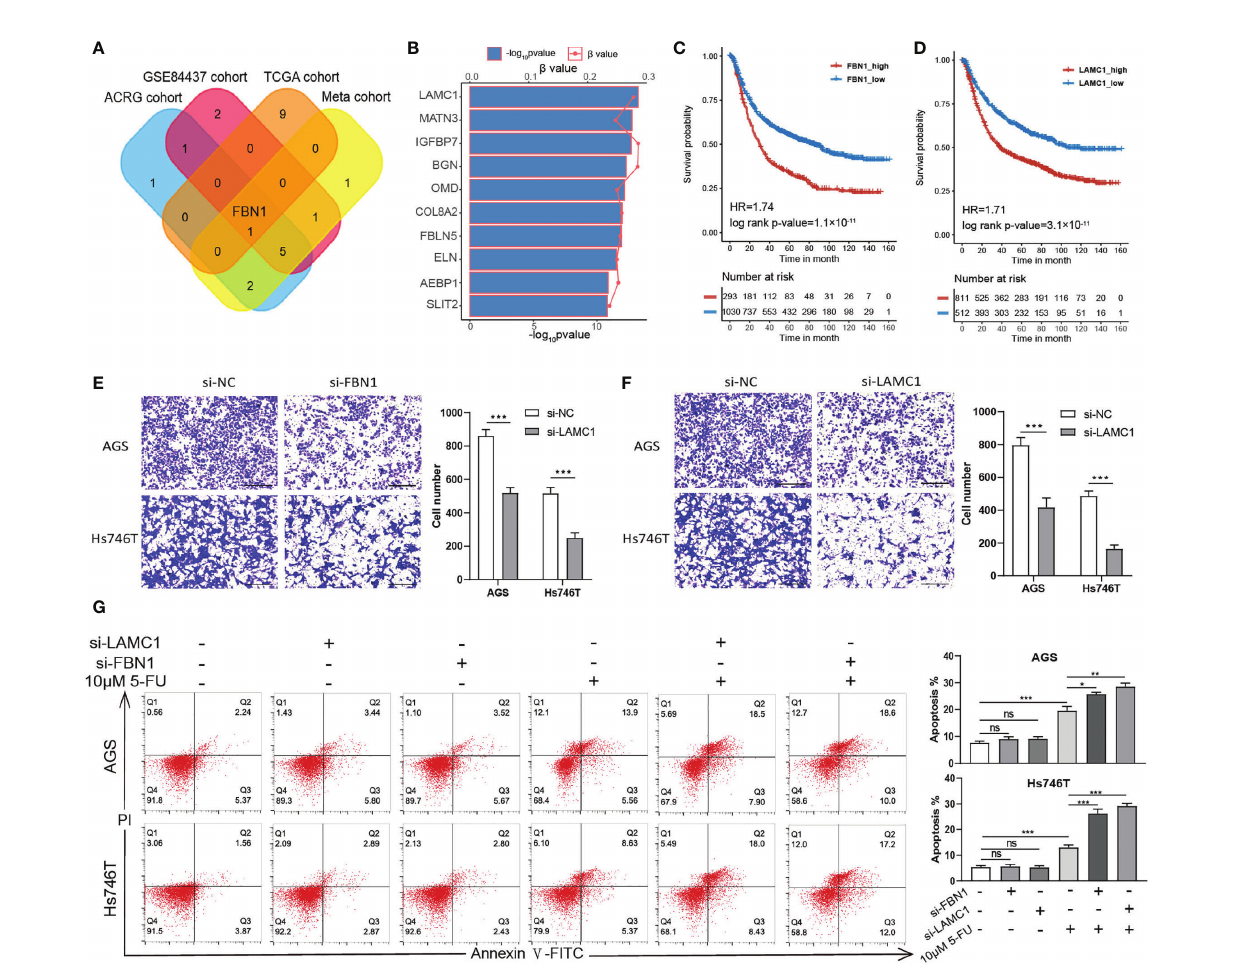
FIGURE 5 | ECM could in fl uence the invasion and drug tolerance of gastric cancer cells. (A) A Venn diagram showing the intersection of top 10 hub ECM genes of four cohorts (TCGA-STAD, ACRG, GSE84437 and meta-cohort). FBN1 is the only common hub ECM gene in the four cohorts. (B) Univariate Cox regression results of all ECM in the meta cohort. The top 10 ECM genes with the lowest p values are shown. The horizontal bars shows the − log 10 p-value of the univariate Cox regression and the horizontal coordinates of the dots show the b value of univariate Cox regression. (C, D) Kaplan – Meier curves for FBN1 and LAMC1 by best cut off value in the meta cohort. FBN1 : HR, 1.74, Log-rank p-value = 1.1 × 10 − 11 . LAMC1 : HR, 1.71, Log-rank p-value = 3.1 × 10 − 11 . (E, F) Transwell invasion assay performed in AGS and Hs746T cells transfected with control siRNA, FBN1 siRNA, or LAMC1 siRNA. (G) Apoptosis was determined using fl uorescence activated cell sorting (FACS) analysis by Annexin V-FITC and propidium iodide (PI) co-staining (left panel), and Annexin V + cell populations were de fi ned as apoptotic (right panel). Statistical p-value (*P < 0.05; **P < 0.01; ***P < 0.001; ns, not signi fi